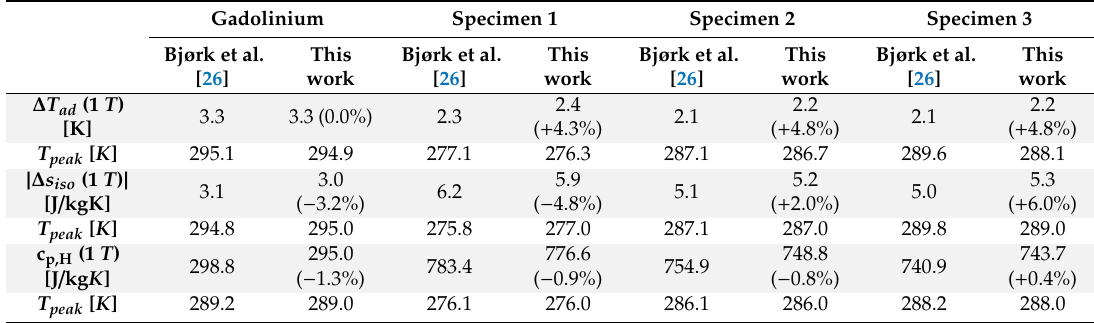
Table 1. Maximum values of the magnetocaloric properties of Gd and the three samples of La-Fe-Co-Si alloy at µ 0 H = 1 T from Bjørk et al. [26] and calculated by the ANN-based procedure.